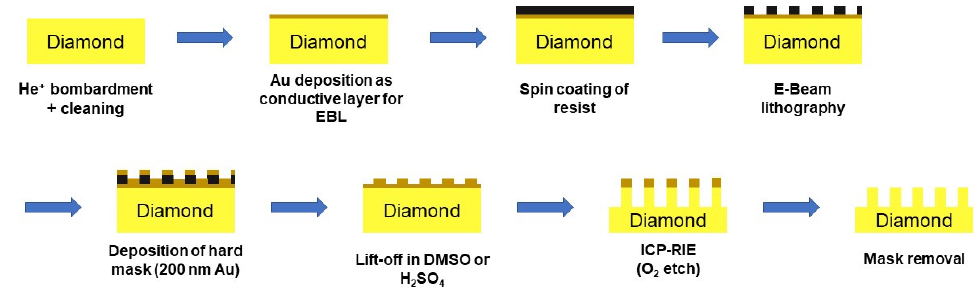
Figure 2. Scheme with the individual steps for the fabrication of nano-pillar arrays in single-crystalline diamond samples.